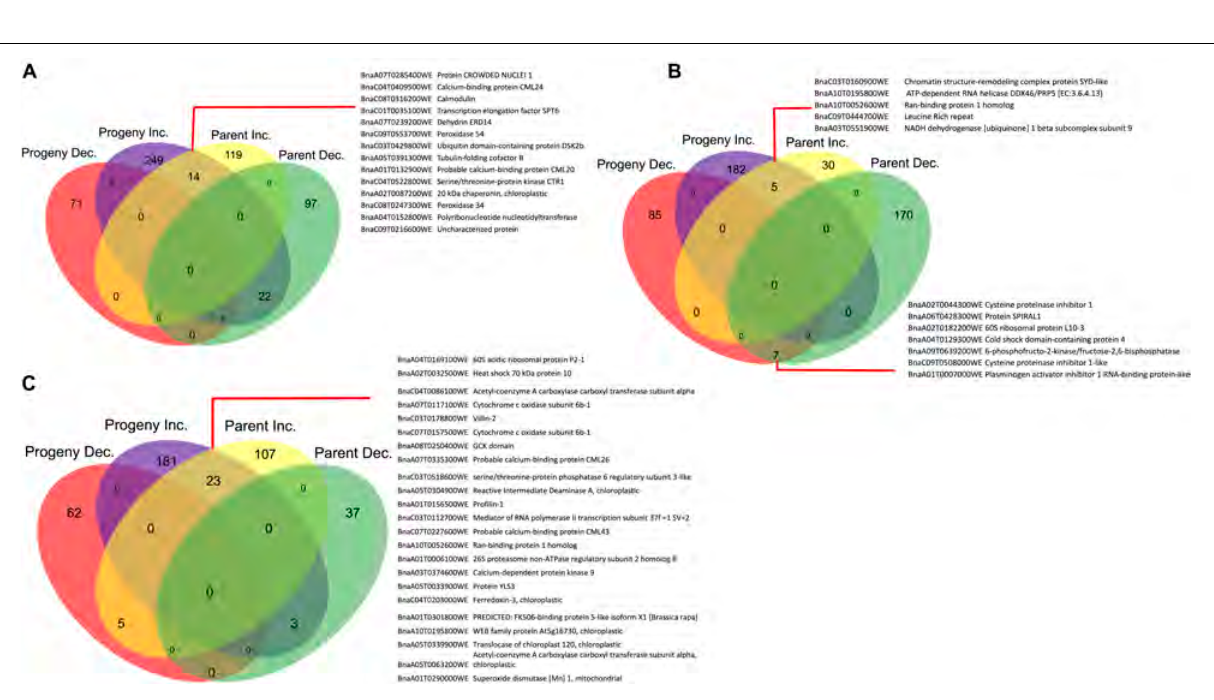
Frontiers in Plant Science |